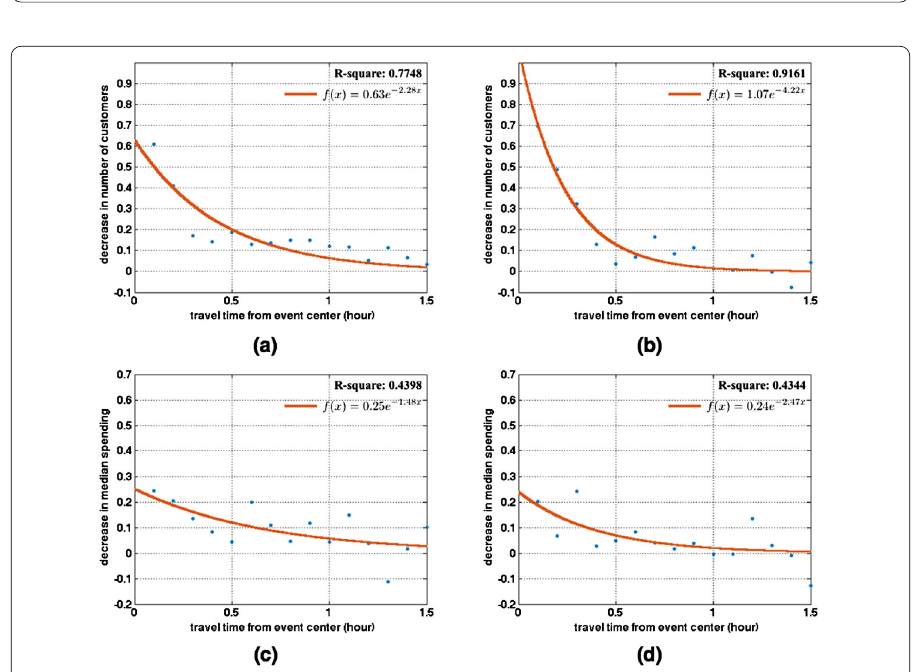
Figure A2 The exponential fit to the median magnitude of decrease in the two behavioral indexes for neighborhoods that are located at different travel time from the event center: ( a ) number of customers on Day 62; ( b ) number of customers on Day 77; ( c ) median spending on Day 62; ( d ) median spending on Day